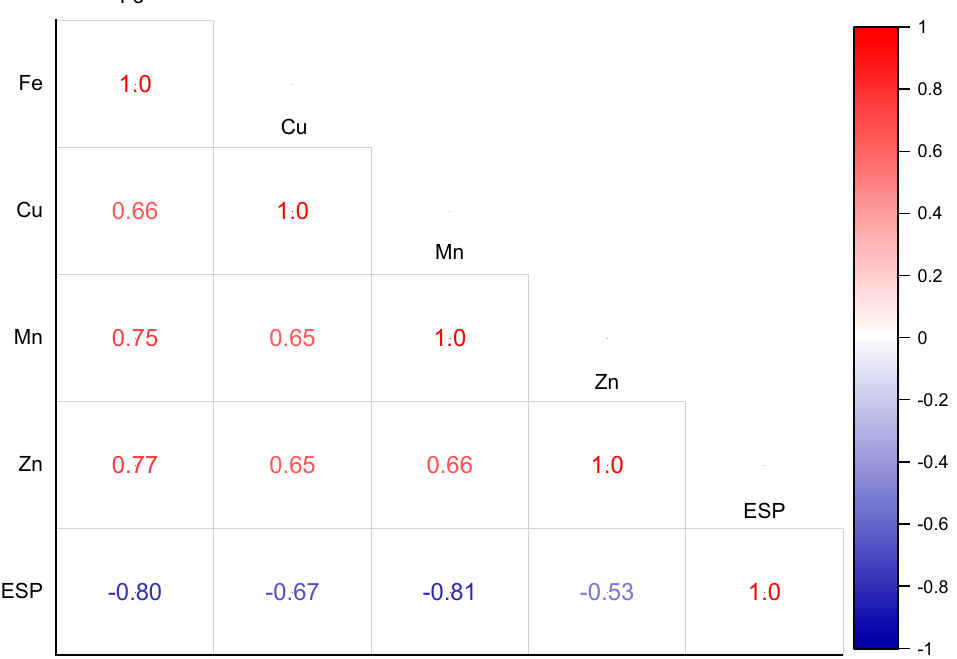
Figure 4. Pearson’s correlation of ESP with micronutrients.